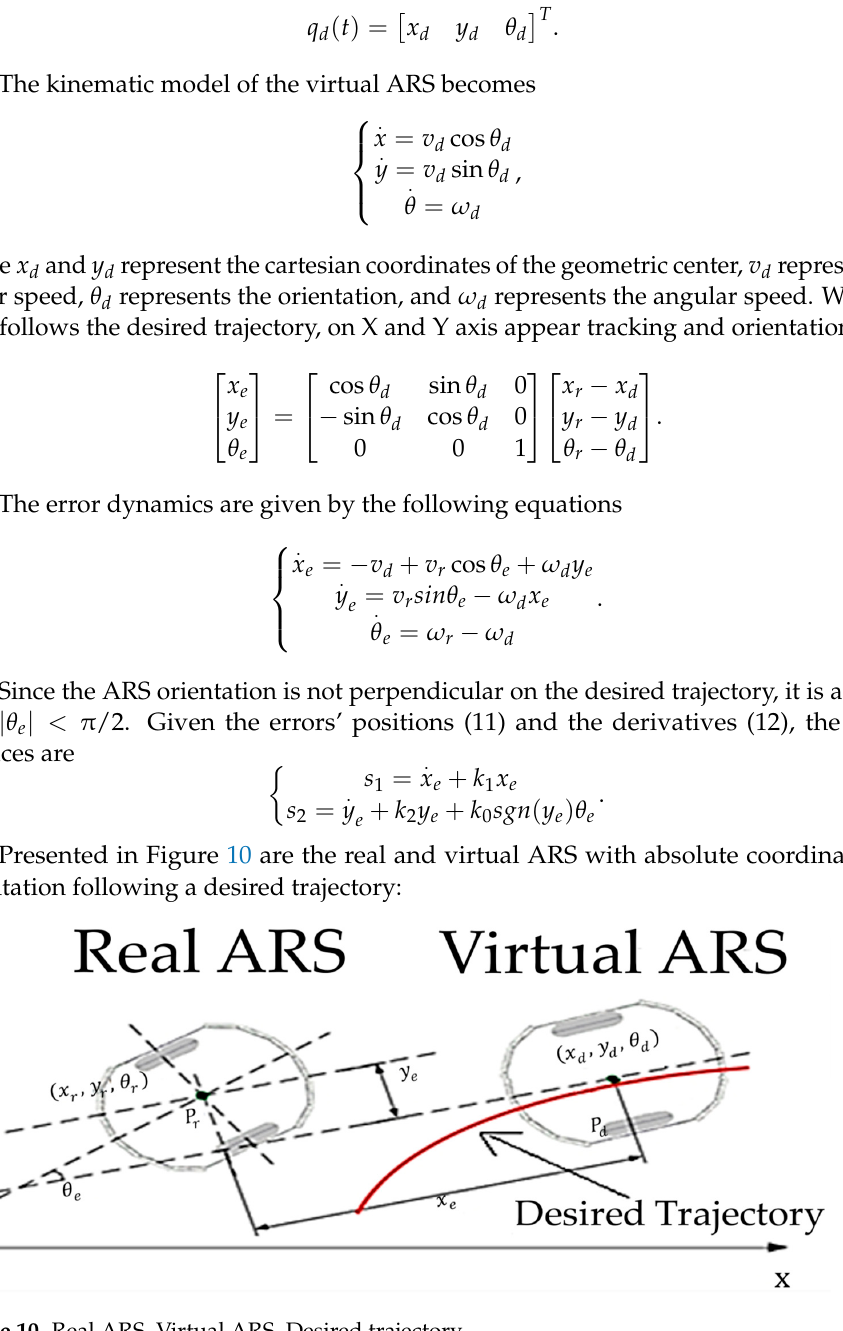
Figure 10. Real ARS, Virtual ARS, Desired trajectory.